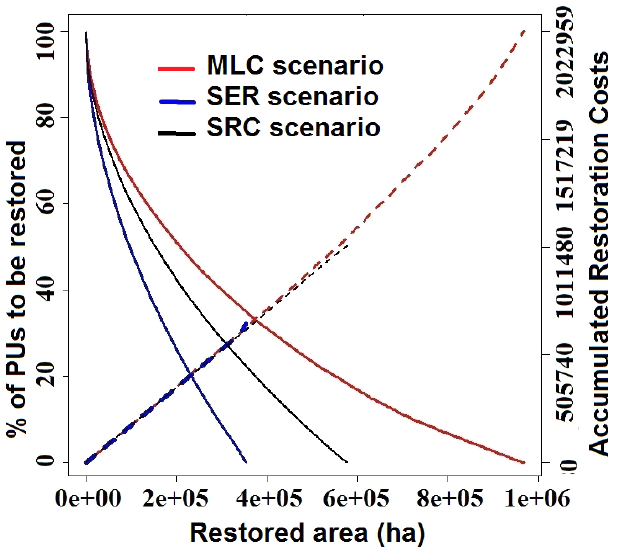
Fig. 5 . In this bidimensional graph we examine the variables: restored area (hectares; x-axis), the percentage of planning units (PUs) to be restored and the accumulated cost of three scenarios (Brazilian Currency Real). The left y-axis (solid line) shows the percentage of PUs to be restored as will fulfill the target (restored hectares). The y-axis on the right (dotted line) shows the accumulated restoration cost for the amount of hectares restored by the